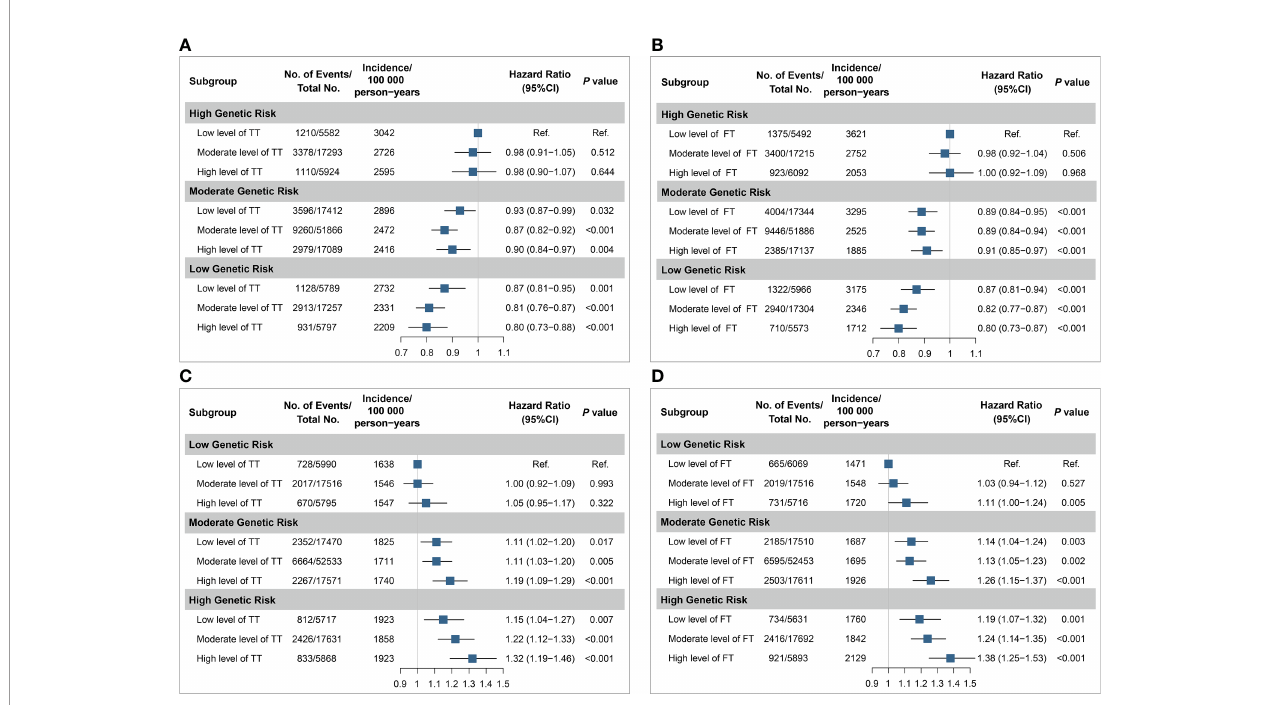
FIGURE 3 | Joint analyses of testosterone and genetic categories for risk of health span termination. The joint effects for health span termination were estimated according to TT of men (A) , FT of men (B) , TT of women (C) , FT of women (D) , and PRS categories, respectively. The blue squares are point estimation of HRs and error bars are 95% CIs. The level of testosterone was divided into three groups: low (quintile 1), moderate (quintiles 2 – 4), and high (quintile 5), and the categories of PRS were similar. Each group was compared with the participants with low level of testosterone and high genetic risk in men, while the combination of low level of testosterone and low genetic risk was the reference in women. Fully adjusted model: age, menopause status (for women), college or university degree, deprivation index, body mass index, smoking status, alcohol drinking, IPAQ group, healthy diet, family history of CCVD or cancer, use of aspirin/ibuprofen, use of hormone replacement therapy (for women), the top 10 principal components of ancestry, and genotyping chip. SHBG was additionally adjusted in total testosterone. HR, hazard ratio; CI, con fi dential interval; Ref., reference; No., number; TT, total testosterone; FT, free